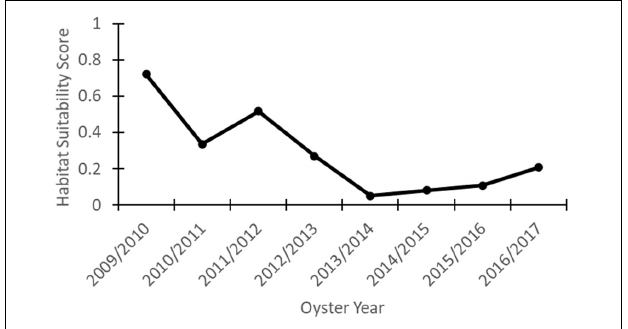
FIGURE 11 | Average habitat suitability over time at the Merrill Shell oyster